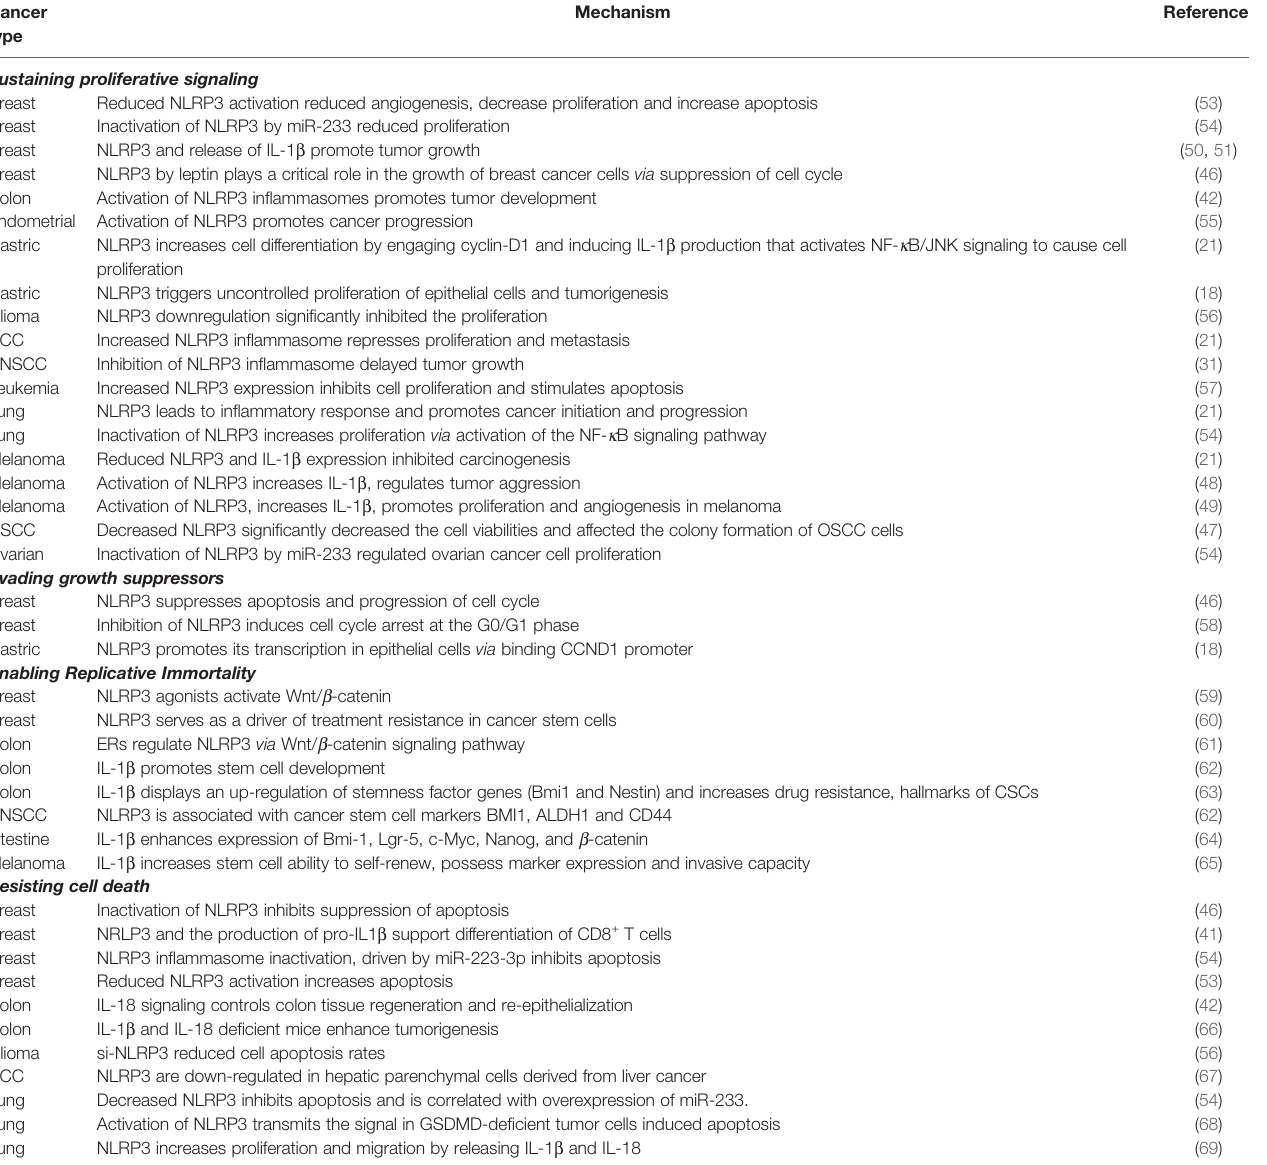
TABLE 2 | Proliferation- and cell death-associated cancer